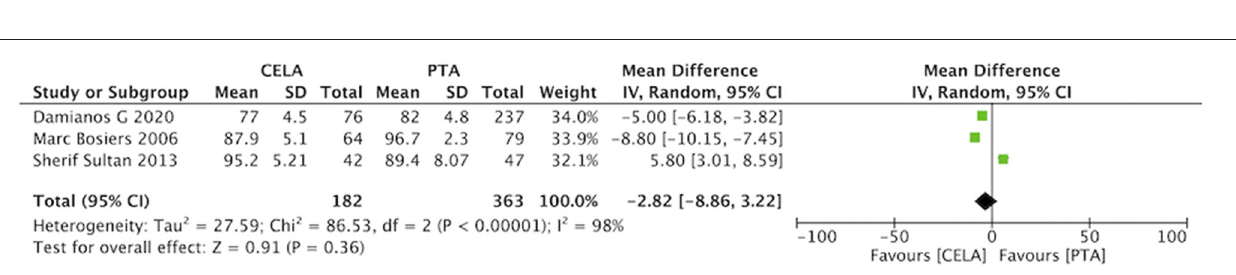
CELA group and the PTA group (MD − 0.17, 95% CI − 1.04-0.70, P < 0.00001) using a random effects model (I 2 = 100%, P = 0.70) ( Figure 7